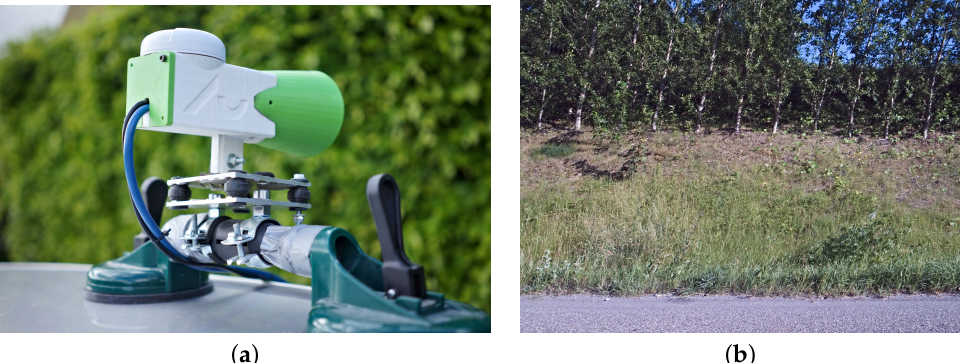
Figure 4. ( a ) The selected camera system that is tested at speeds up to 130 km/h. It consists of Daheng MER-1220-32U3C camera with 8mm lens and u-blox 8 UBX-M8030-KT GNSS receiver that are mounted on the car roof with suction cups. ( b ) Sample from Daheng MER-1220-32U3C with an 8mm lens and 100 µs exposure time, while driving 110 km/h. Notice the leaning of the trees, which is a result of the rolling